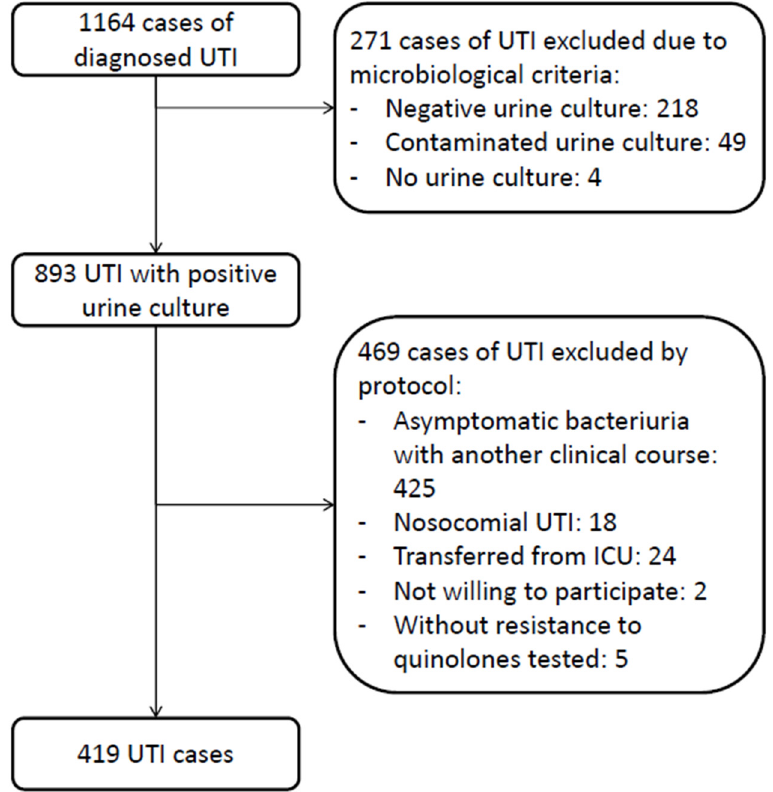
Figure 1. Flowchart of inclusion of 419 cases of complicated community-acquired urinary tract in ‐ fection.